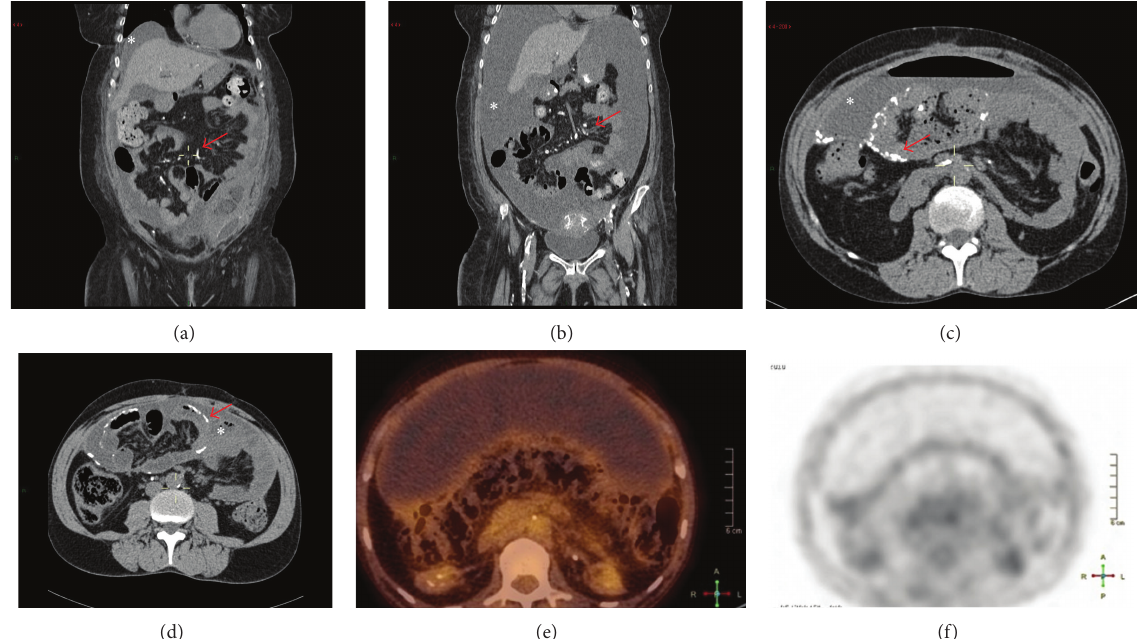
Figure 1: Radiological findings suggesting encapsulating peritoneal sclerosis (EPS). (a, c and b, d correspond to cases EPS 2 and EPS 3, resp.) Abdominal computed tomography without contrast agent showed massive nonloculated fluid and bowel loops drowned into the center of the abdominal cavity suggestive of bowel adhesions. As compared with EPS case 2, EPS case 3 presented more abundant abdominal ascites, marked narrowing of bowel lumen and thickening of visceral and parietal peritoneum, absence of dilated bowel loop, air-fluid levels or entrapped fluid collections, and several calcifications in both parietal and visceral peritoneum. (e and f, case EPS 3) Fluorodeoxyglucose 18 positron emission tomography (F 18 PET) scan showed a mild increase in the tracer uptake in the peritoneal areas.